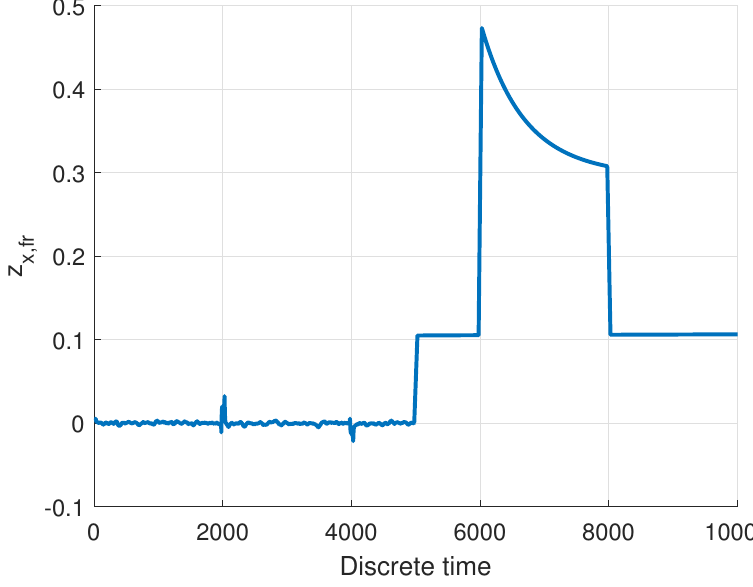
Figure 11. Residual z x , fr for the faulty